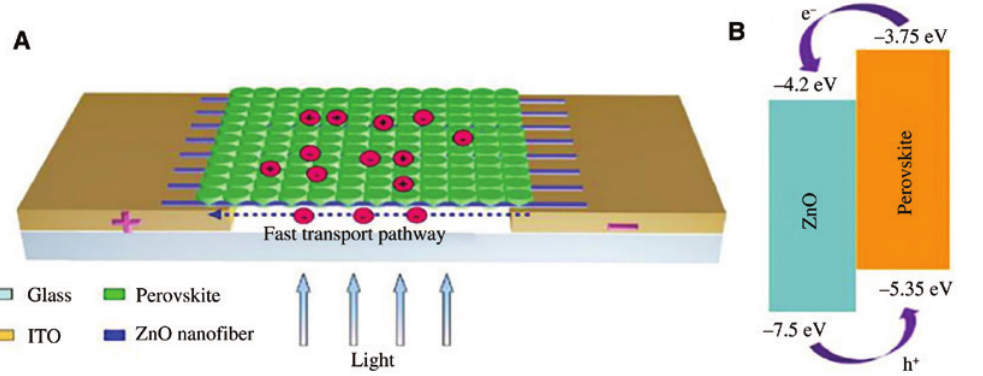
Figure 8: Schematic and band energy of ZnO nanofiber. (A) Schematic of ZnO nanofiber and perovskite hybrid PDs. (B) Band energy alignment between ZnO and perovskite. Reproduced with permission from Ref.